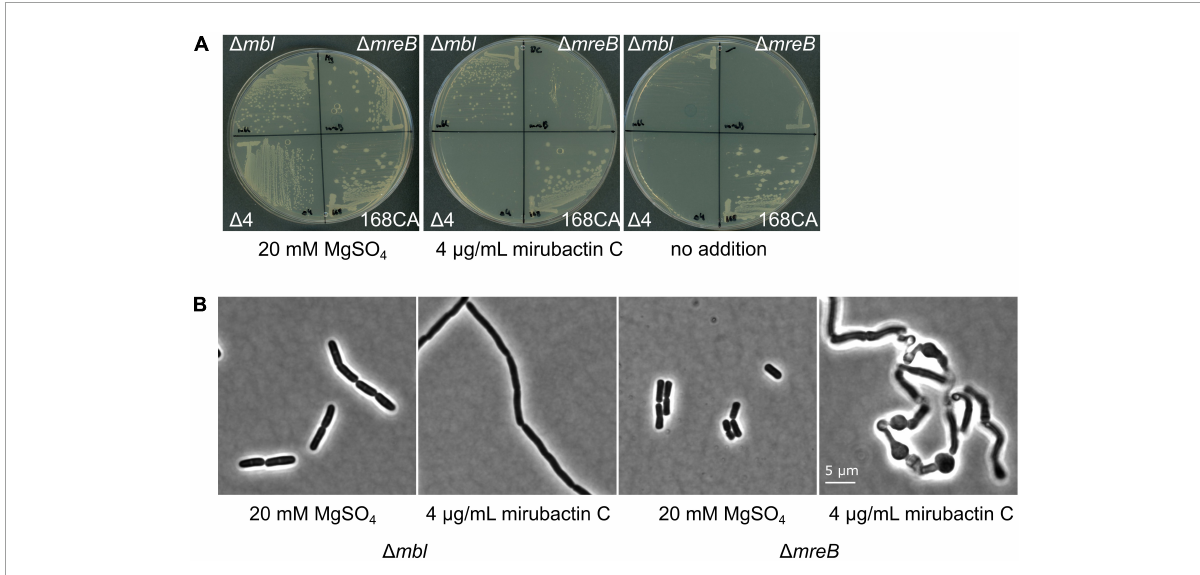
FIGURE4 Effects of divalent cations and mirubactin C on several MgSO 4 -dependent cell wall mutants. (A) Growth behavior of Bacillus subtilis 168CA (wt) and (cid:49) mbl , (cid:49) mreB, (cid:49) 4 mutant (which lacks ponA and genes for the 3 other class A PBPs) on PAB plates in the presence of 20 mM MgSO 4 , 4 µ g/ml mirubactin C and in the absence of any additive. (B) Phenotype of Bacillus subtilis mutants (cid:49) mbl and (cid:49) mreB in the presence of MgSO 4 and 4 µ g/ml mirubactin C.